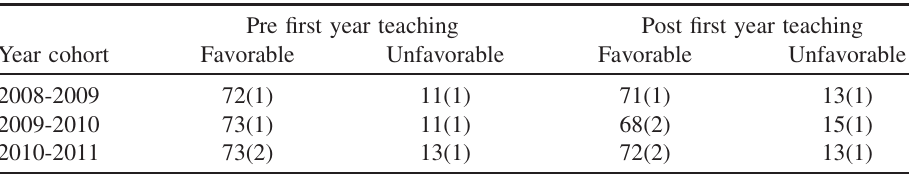
TABLE II. Overall percentages of favorable and unfavorable CLASS responses, compared to expert views, for three consecutive first year cohorts ( N ¼ 111 ; 93 ; 54 ), collected pre and post first year teaching. Values in brackets denote the standard error.